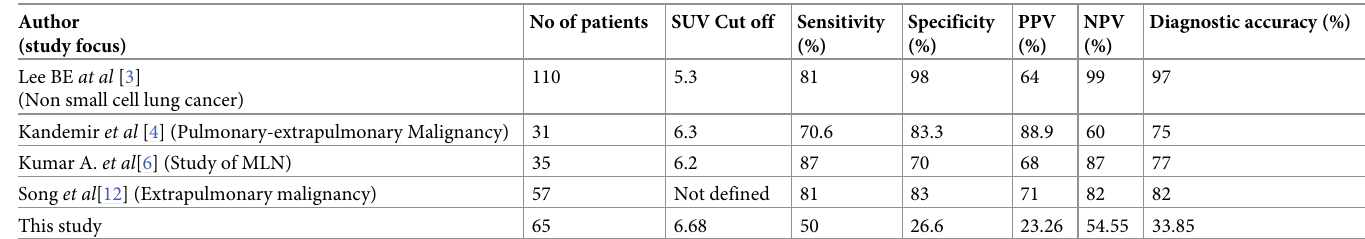
Table 2. Utility of PET- CT in diagnosis of malignancy with average SUV cut